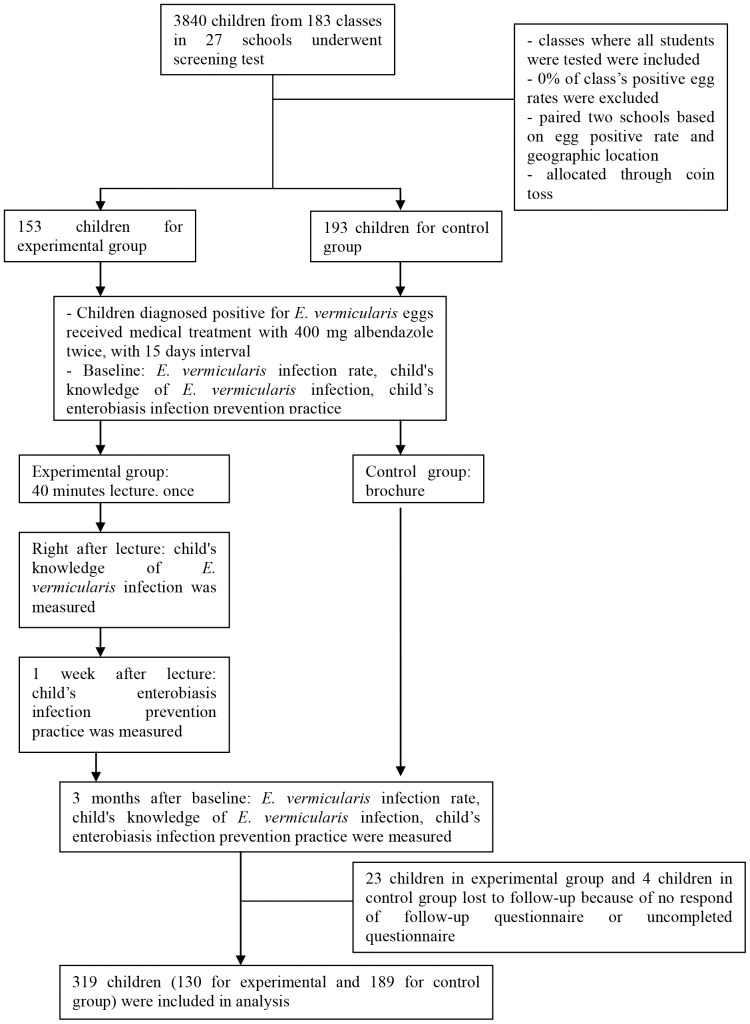
Study design including screening, group allocation, and follow-up.A total of 319 children from 16 classes were invited from among 3,840 children screened from 183 classes. The schools were assigned to either the intervention or the control arms by simple randomization using a coin toss.